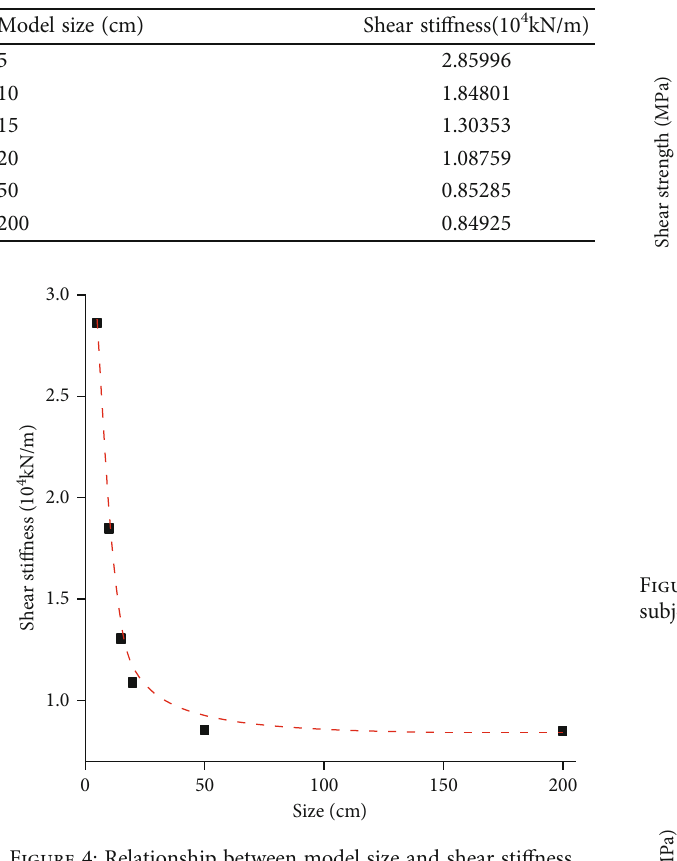
Figure 4: Relationship between model size and shear sti ff ness.